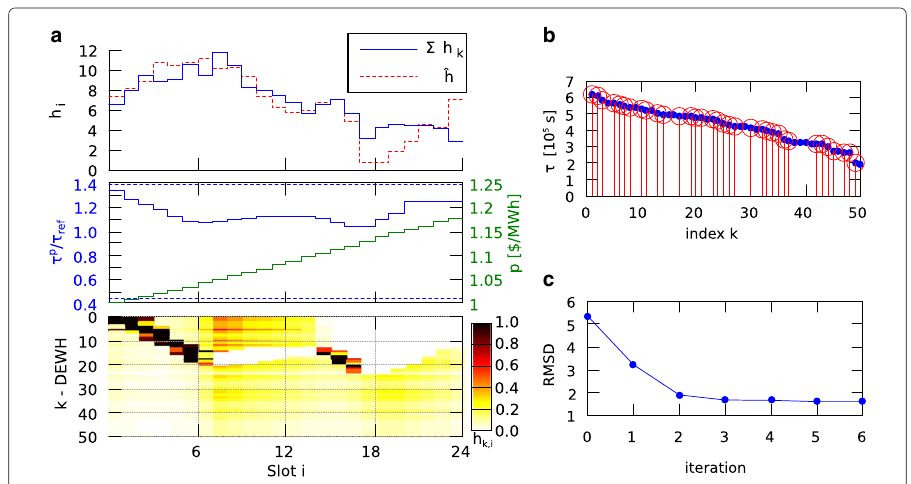
Fig. 4 Results for τ -price with fixed 1-day horizon and virtual power availability. a Resulting aggregated and individual heating profiles, τ p and p , b τ -Cluster: τ -values between lines belong to one cluster, c Resulting error in